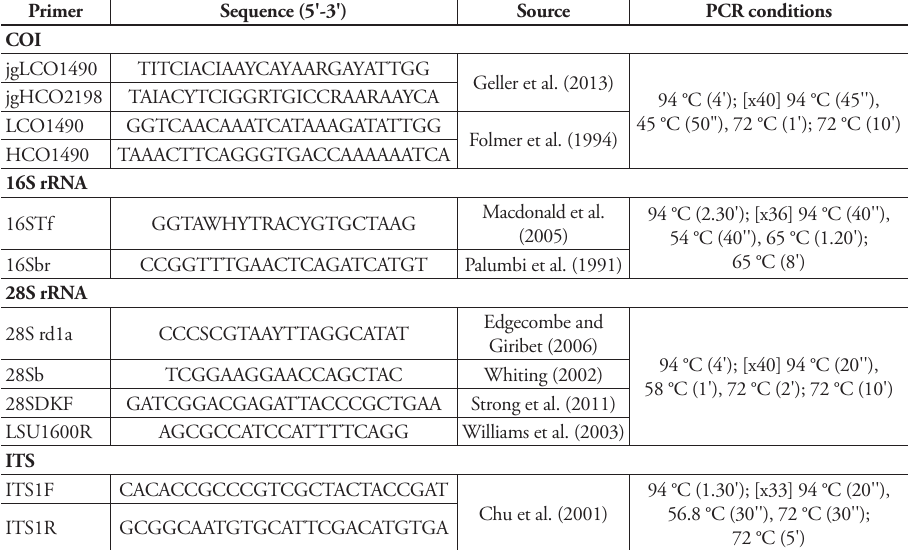
Table 2. Primers used for amplification and PCR conditions used in the present